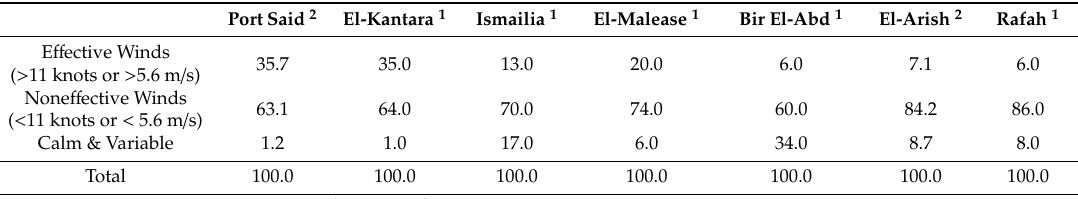
Table 7. Percentage of wind occurrences according to speed in North